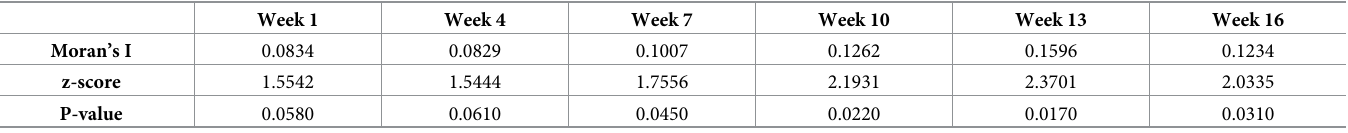
Table 2. Moran’s I value for internet attention.